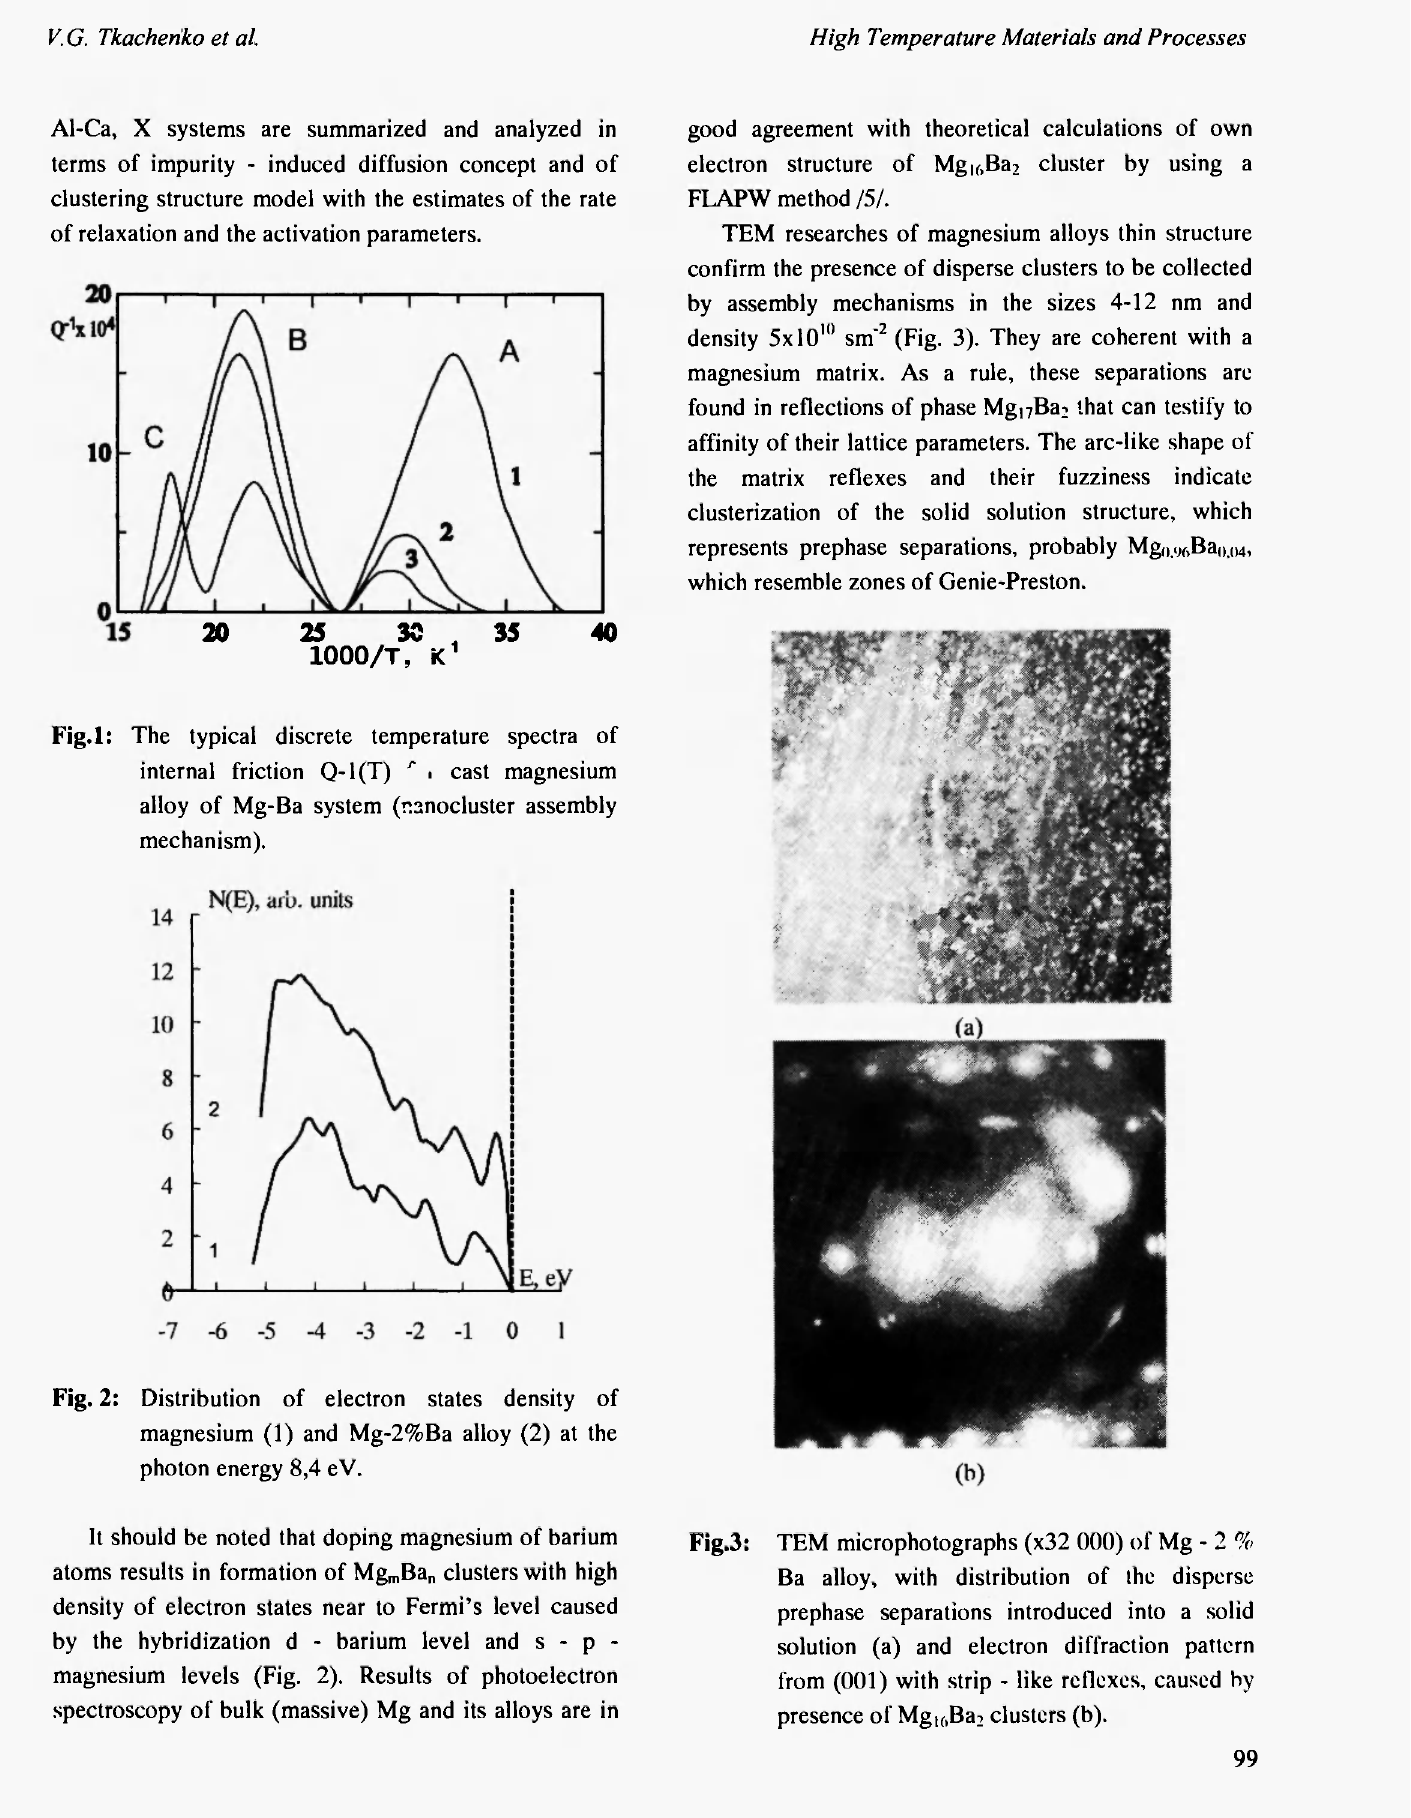
Fig.3: TEM microphotographs (x32 000) of Mg - 2 % Ba alloy, with distribution of the disperse prephase separations introduced into a solid solution (a) and electron diffraction pattern from (001) with strip - like reflexes, caused by presence of Mg u ,Ba2 clusters